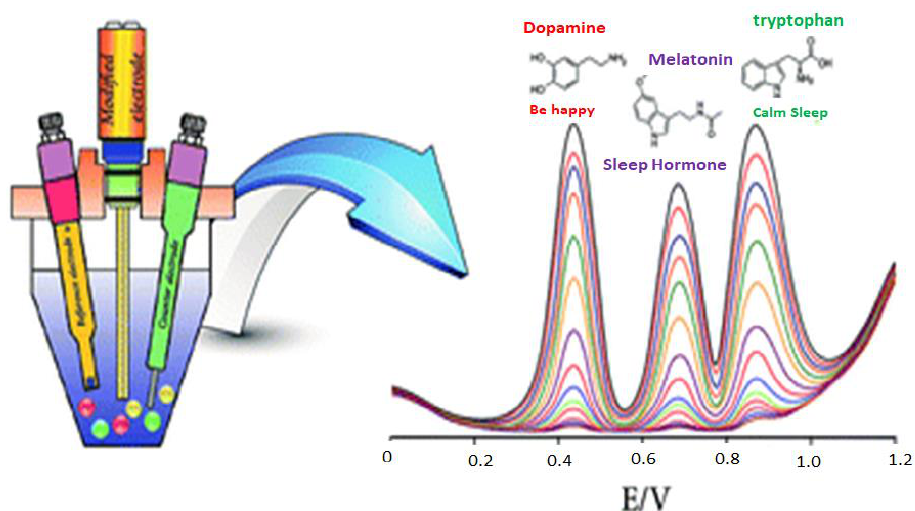
Figure 4. Differential pulse voltammetry (DPVs) for the determination of melatonin (MLT) at the N -reduced graphene oxide (rGO)/CuCo 2 O 4 /carbon paste electrode (CPE) in the presence of 2 mM dopamine and tryptophan. Taken from Tadayon et al. [166] .